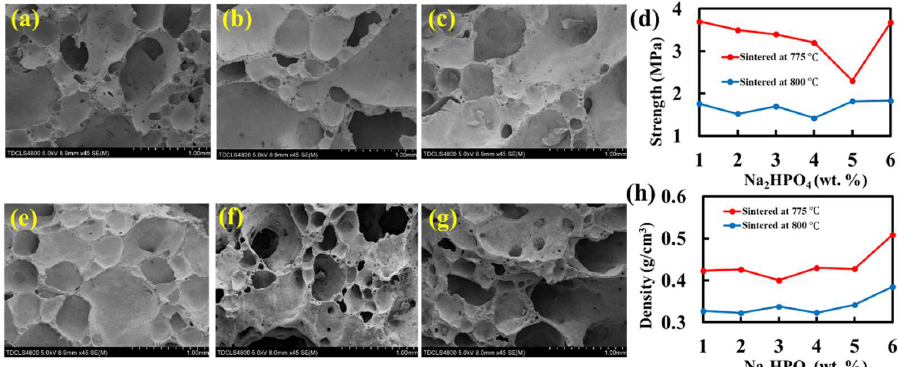
Figure 4. Pore surface morphology of the foam glass samples by SEM stabilized by: ( a ) 1 wt.%; ( b ) 2 wt.%; ( c ) 3 wt.%; ( e ) 4 wt.%; ( f ) 5 wt.%; ( g ) 6 wt.% Na 2 HPO 4 , under a sintering temperature of 775 °C. The trend of ( d ) compressive strength and ( h ) density as a function of different amounts of Na 2 HPO 4 under two sintering temperatures of 775 °C and 800 °C.